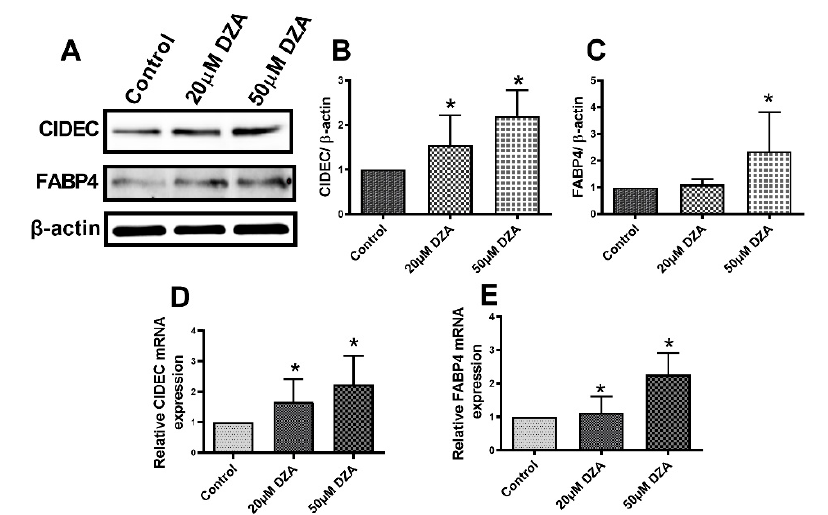
Figure 5. CIDEC and FABP4 expression in control and DZA-treated hepatocytes. ( A ) Representative WesternblotshowingCIDECandFABP4levelsincontrolandDZA-treatedhepatocytes. ( B )Immunoblot analysis summarizing the protein band density of CIDEC to β -actin, n = 3 experiments and ( C ) FABP4 to β -actin, n = 3 experiments. ( D ) Relative CIDEC mRNA and ( E ) FABP4 mRNA expression in control and DZA-treated hepatocytes ( n = 7 experiments). Asterisks indicate values for DZA-treated hepatocytes are statistically di ff erent from controls (* p ≤ 0.05 vs. Control).